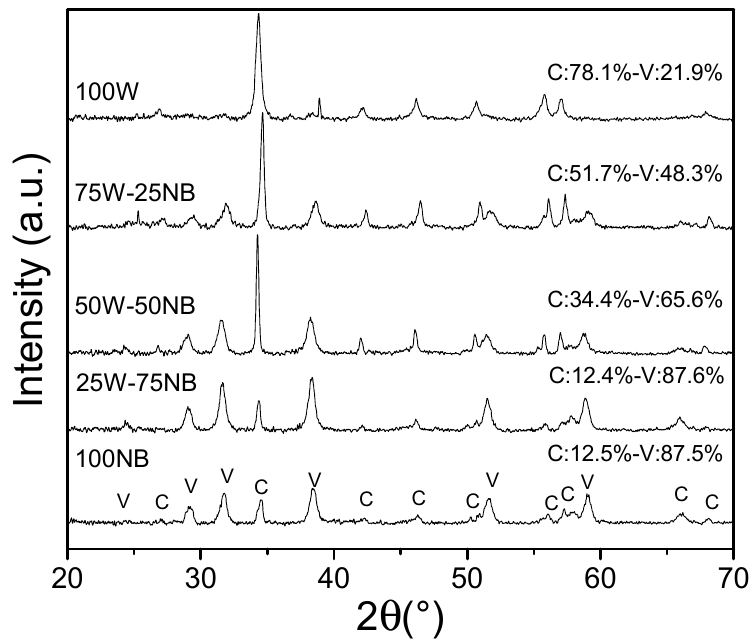
Figure 3. XRD of whey effect on biogenic CaCO 3 production.